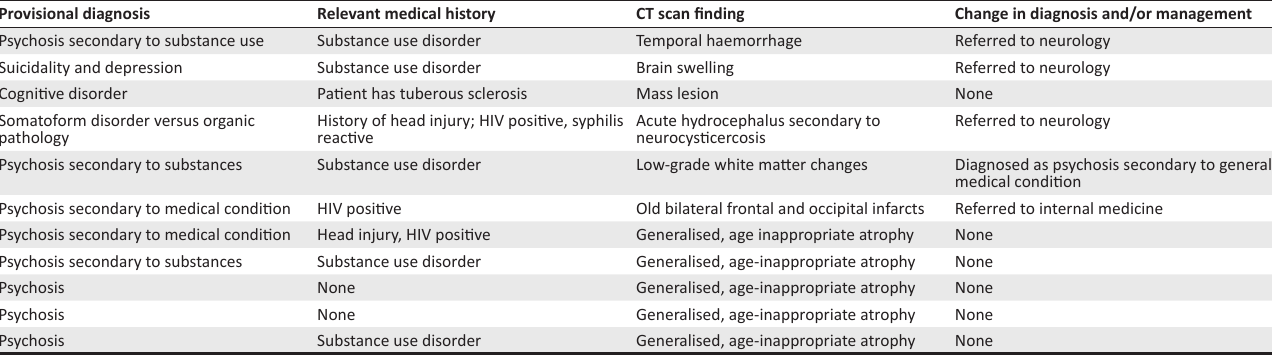
TABLE 3: Clinical features, diagnosis and management of six patients with clinically significant computerised tomography abnormalities .